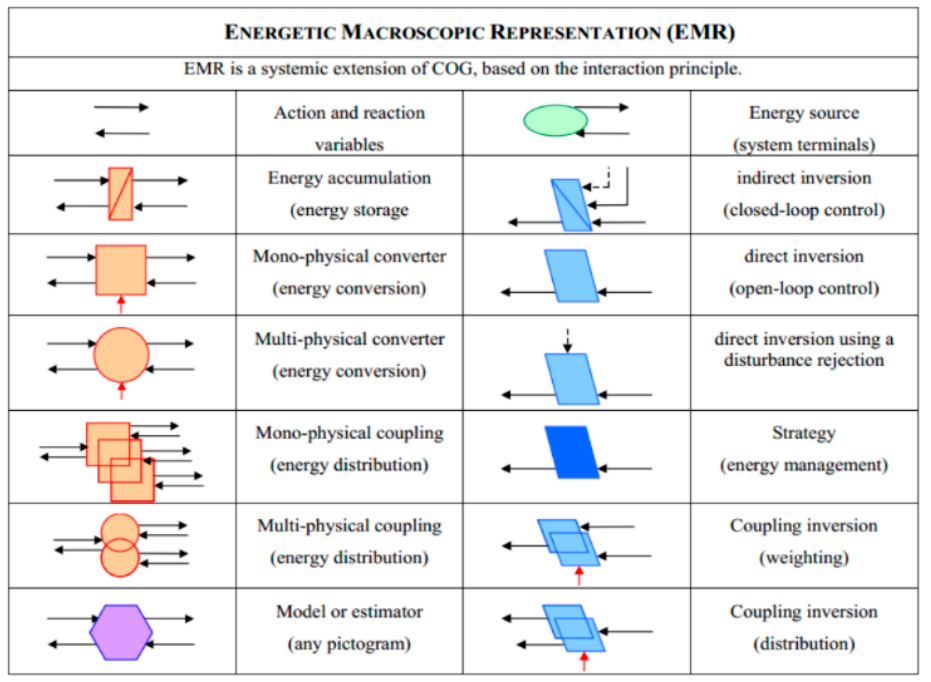
Figure 5. EMR structure for multi-applications. The structure for multi-architectures before the torque-coupler is presented by Figure 6. It consists of three energy sources of HEV (ICE, EM1 and EM2). By changing the ICE fuel map, EM efficiency map and the energy source parameters, this part could be used to represent different HEVs’ powertrains. The torque-coupler system could be modified to represent three different hybrid architectures. The torque-coupler system can be seen as an interface between energy sources and vehicle sources.